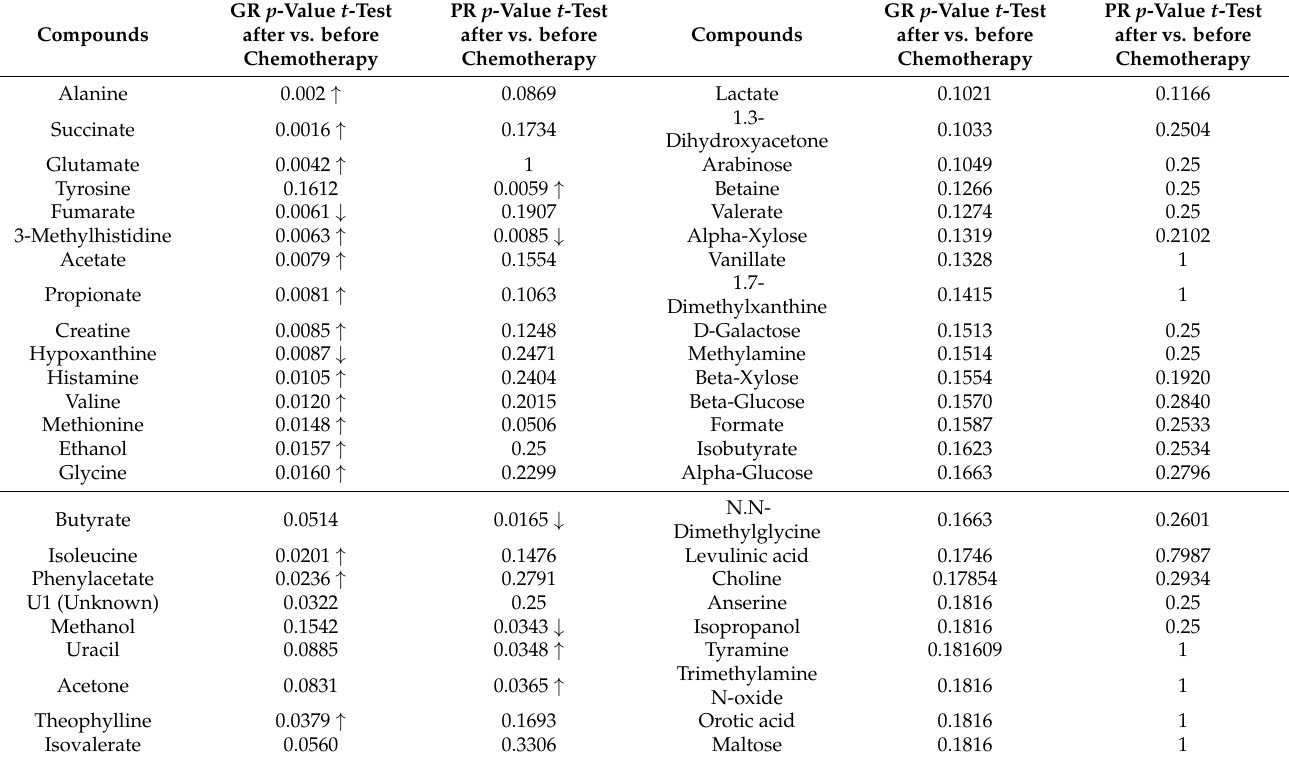
Table 4. Changes of the metabolite levels before and after the